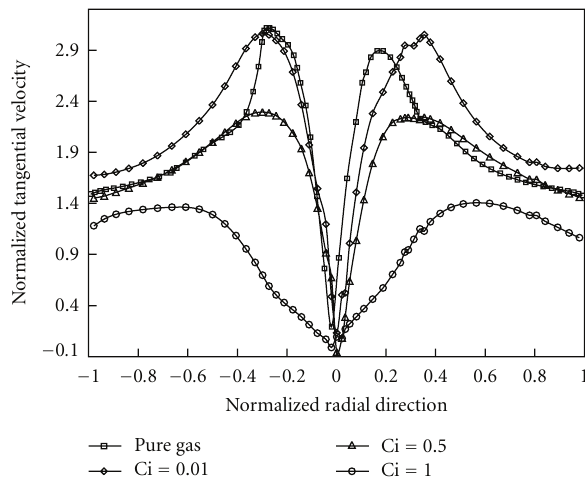
Figure 6: E ff ect of the particle loading on the tangential velocity.